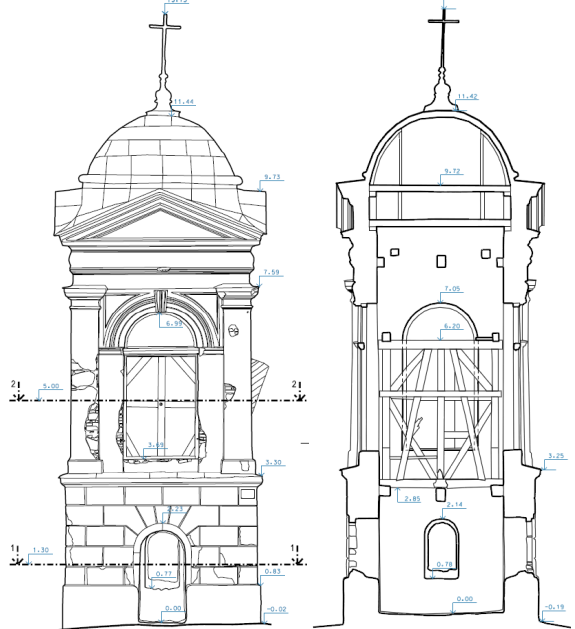
Figure 20. Vector plan of the exterior wall (left) and vertical section view